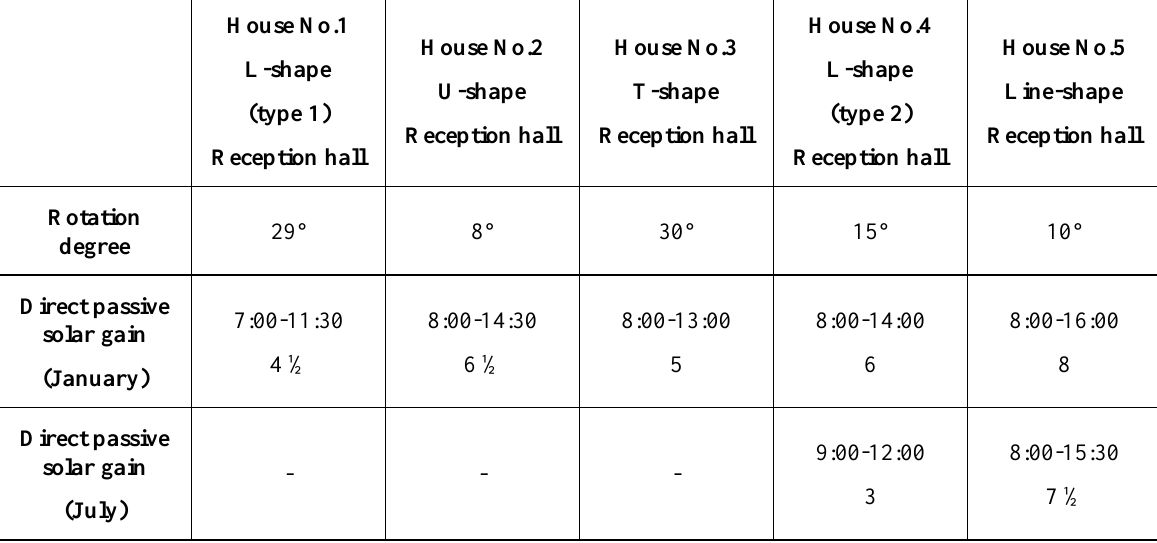
Table 3 Hours of direct solar radiation for houses No.1-5 regarding the main living space (Source: Author)